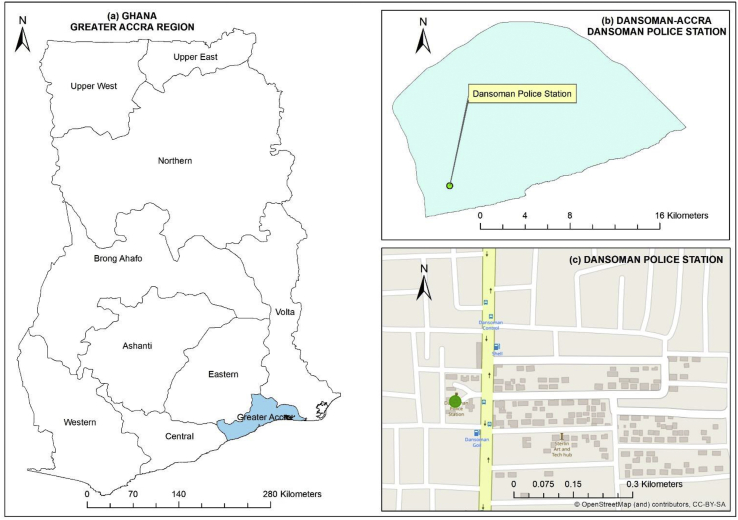
Overview of the Dansoman-Accra site deployment (a. overview of the greater Accra region; b area of the Dansoman police station; c street map overview nearby the Dansoman police station; Green circle: location of the node collocated ~10 cm apart with the GhEPA monitoring reference device) GhEPA (5°32′28″N 0°16′8″W).